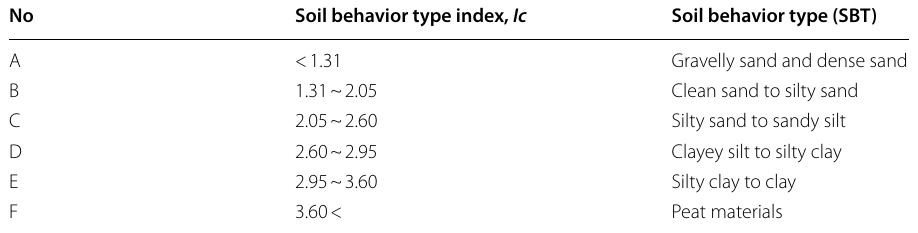
Table 2 CPT soil behaviour